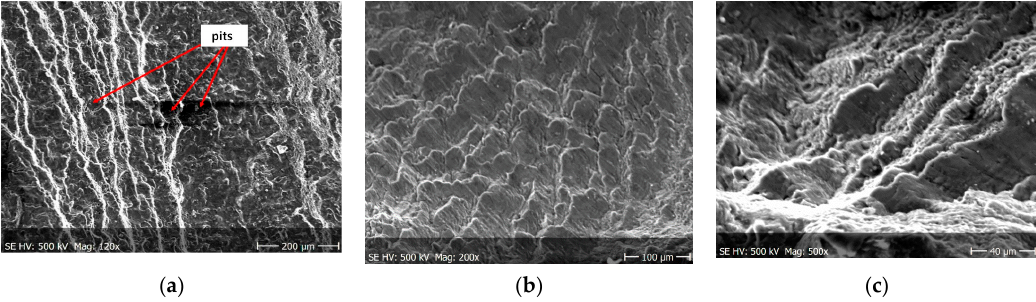
Figure 13. ( a – c ) . Fracture images after 14 days in demineralised water (images taken at fracture surface of sample shown in Figure 5b).